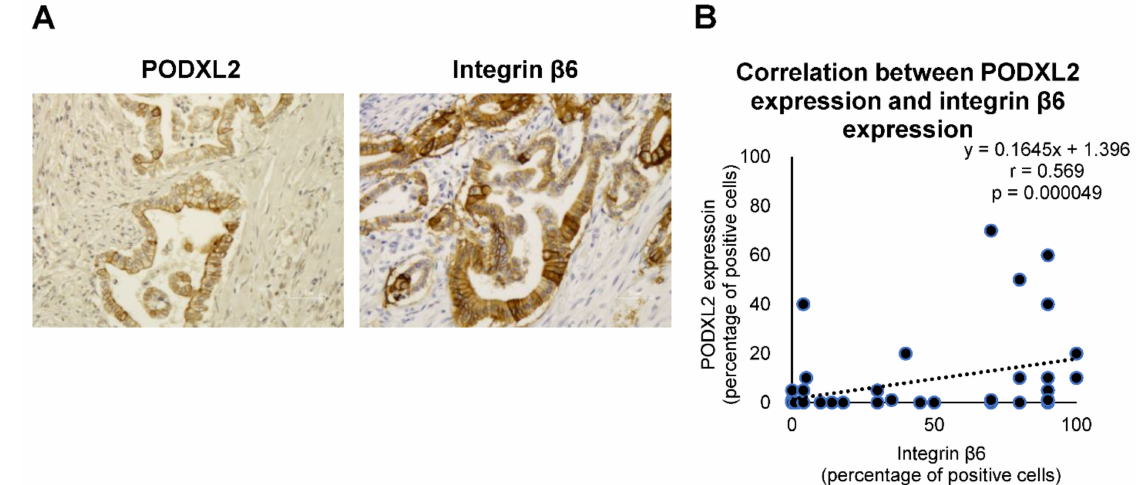
Figure 7. Expressions of PODXL2 and integrin β 6 in intrahepatic cholangiocarcinoma tissue. ( A ) PODXL2 and integrin β 6 are shown in the cell membrane and cytoplasm of tumor cells. PODXL2 expression patterns resemble integrin β 6 expression patterns. Scale bar, 50 µ m. ( B ) Correlation between PODXL2 expression and integrin β 6 expression within tumors was significant ( r = 0.569, p =